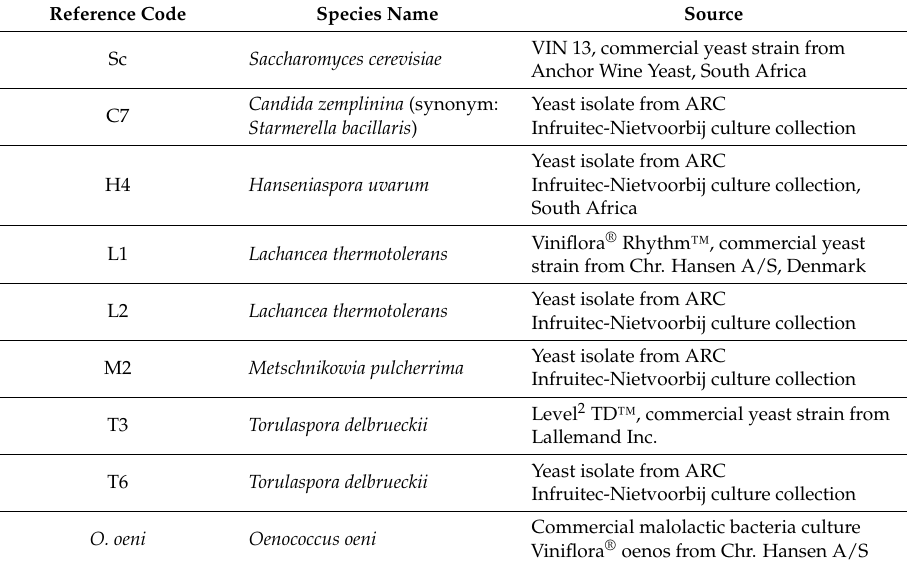
Table 1. Yeasts and lactic acid bacterium used in this